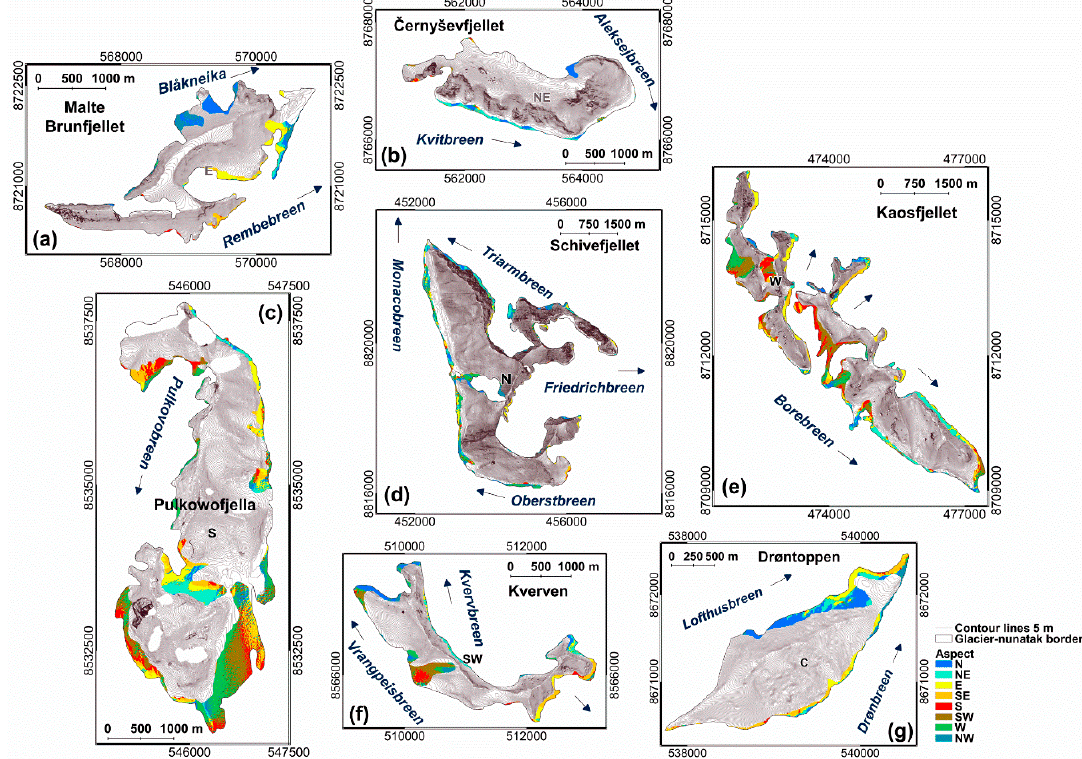
Figure 5. Percentage share of slope exposure for the nunataks visible on images from 1985–1992 in Spitsbergen.